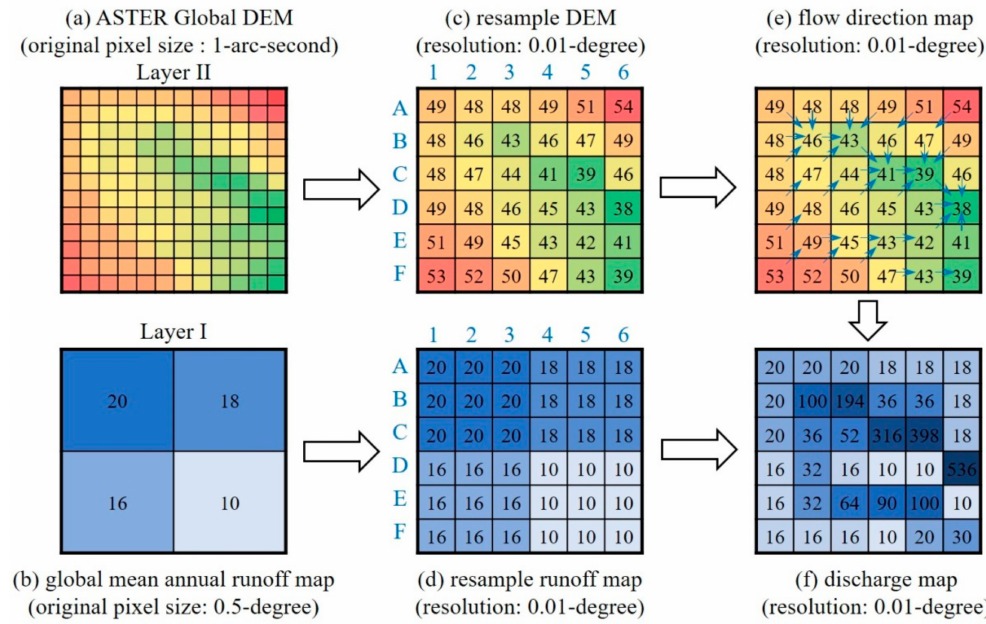
Figure 2. A framework diagram of the mapping method. ASTER: Advanced Spaceborne Thermal Emission and Reflection Radiometer; DEM: digital elevation